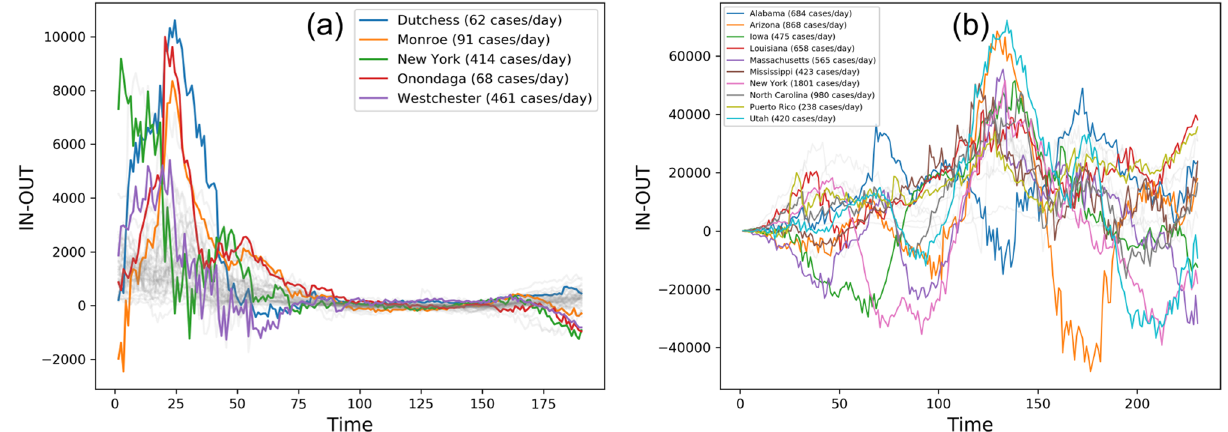
Figure 6. Most affected zones with the corresponding COVID-19 daily infection numbers. ( a ) NY counties and ( b ) US states showing a high difference between inflow and outflow measured in terms of difference between weighted out-degree from weighted in-degree.